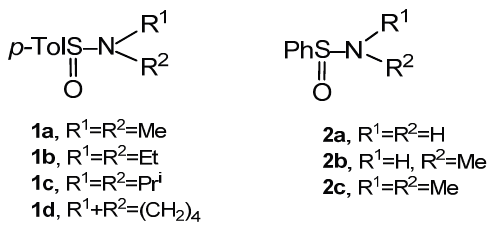
Figure 1. Optically active